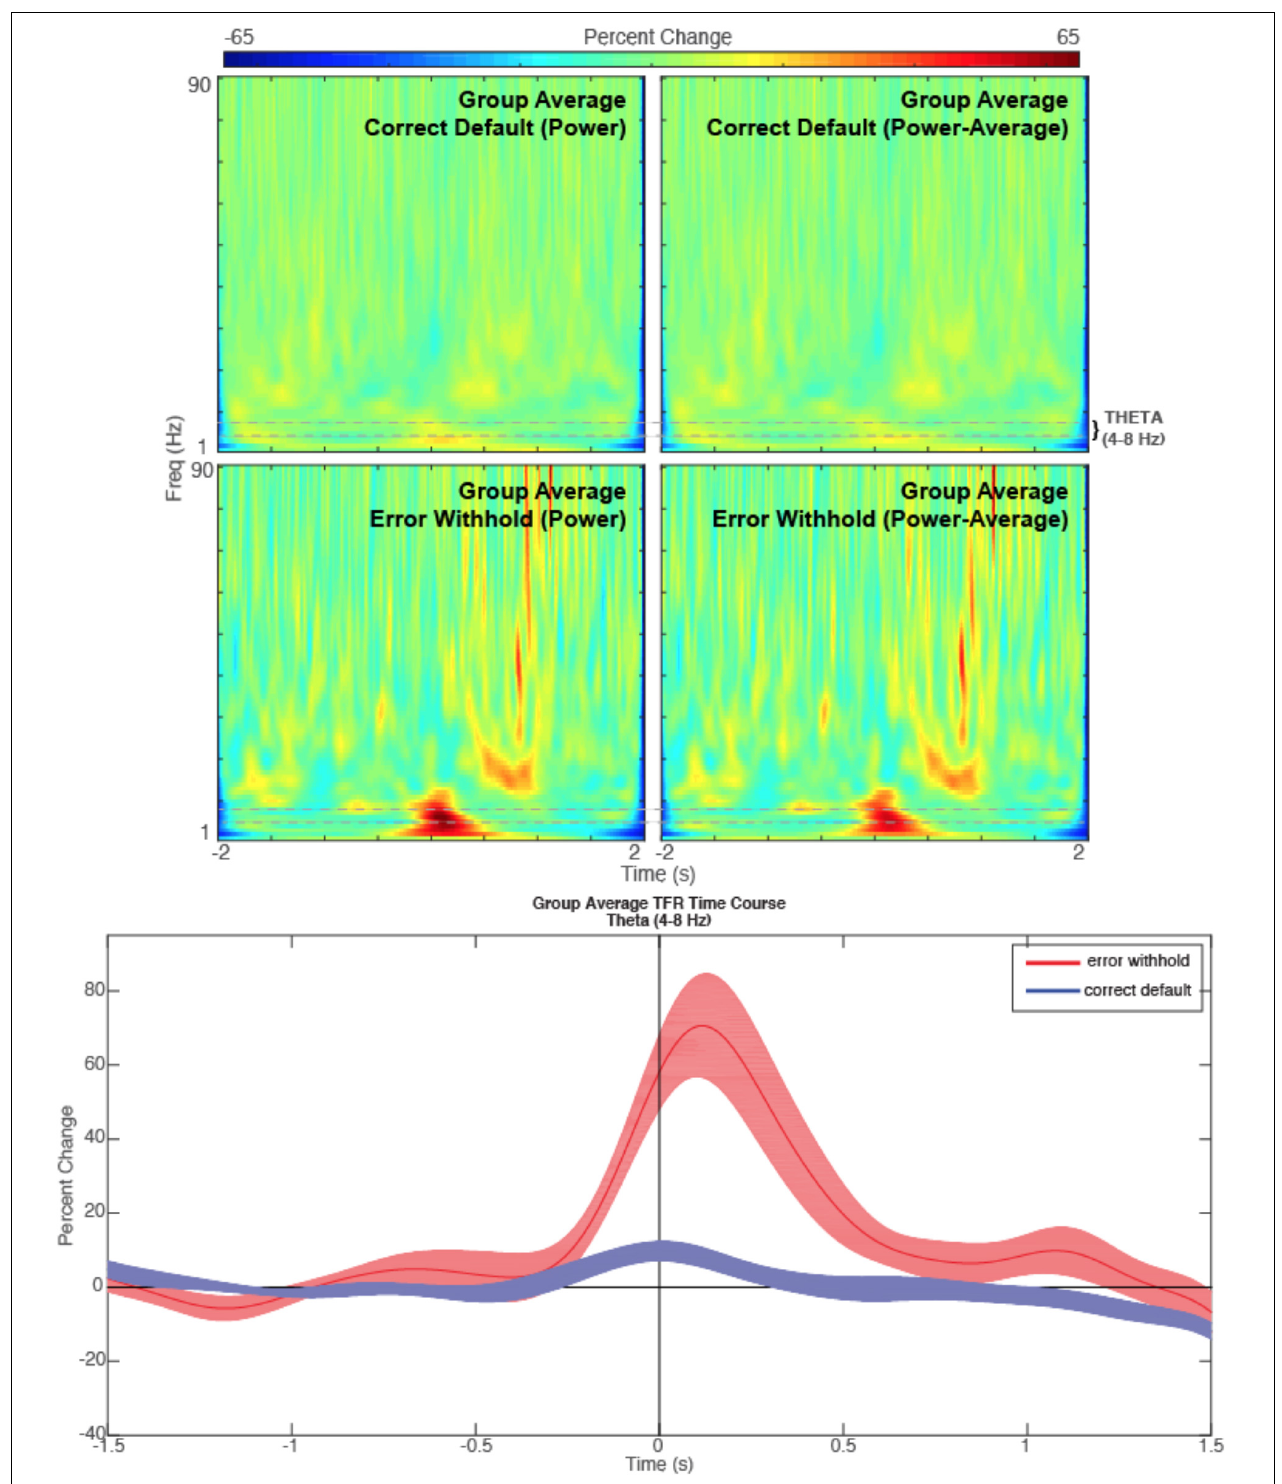
FIGURE 8 | Theta. Time-frequency representations are shown for the R Anterior Cingulate peak (top) generated from a contrasted (error withhold > correct default) group theta band (4–8 Hz) beamformer as described. Note that the theta band power remains present in error peaks when phase-locked activity is removed (power minus average). A time course of the theta band TFR is represented (bottom) with shaded error bars for each condition described.